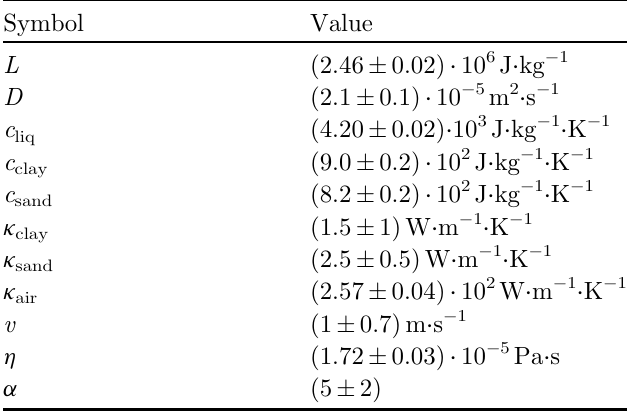
Table 1. Values of the parameters used in our